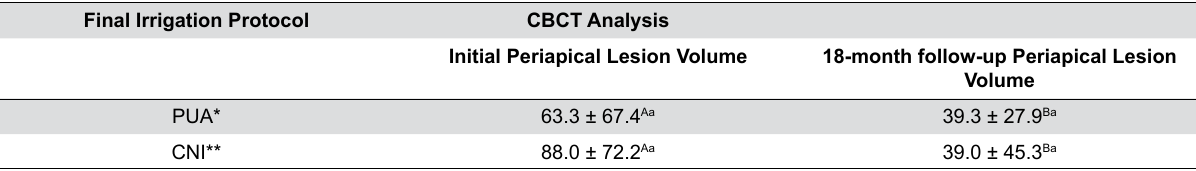
Figure 5- Bacterial levels before root canal treatment (S1), after instrumentation with PUA* or CNI** (S2) and after final irrigation using EDTA with PUA or CNI (S3) Table 3- Effectiveness of PUA and CNI protocol in reducing periapical lesion volume in primary endodontic infection [Different letters mean statistically significant differences (p<0.05). Uppercase letters indicate difference in the line (intra-groups) and lowercase letters indicate difference in the column